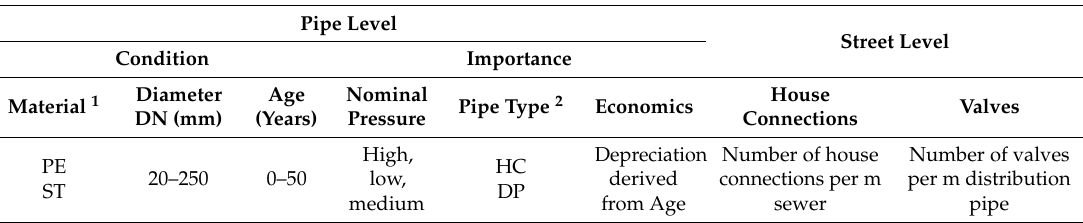
Table 3. Influencing factors for the gas distribution